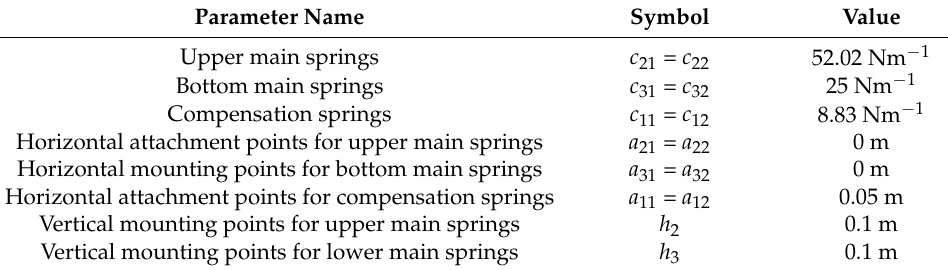
Table 1. Geometric and elastic parameters describing the tested